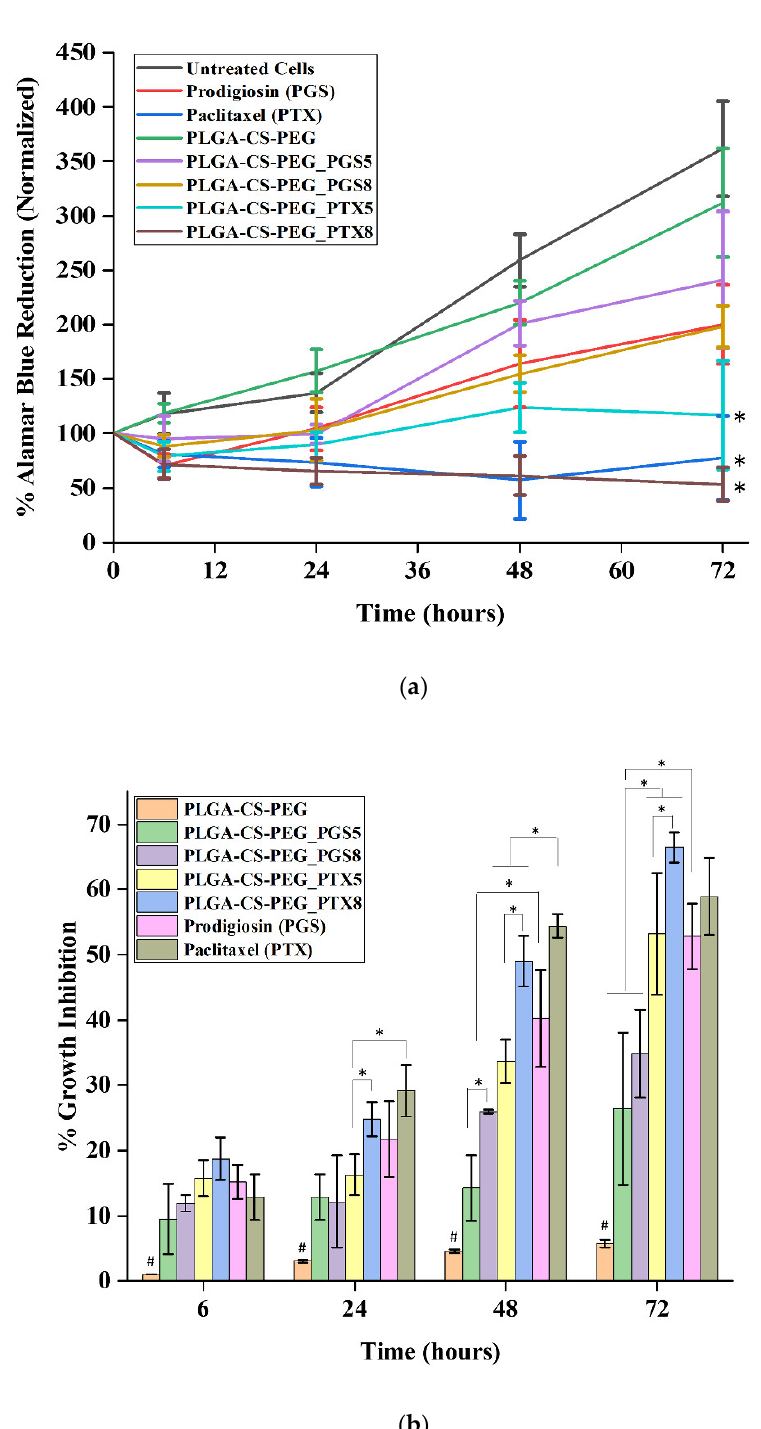
Figure 6. ( a ) Percentage Alamar blue reduction for untreated MDA-MB-231 cells and MDA-MB-231 cells treated with nonloaded microspheres, PGS, PGS-loaded microspheres, PTX, and PTX-loaded microspheres at 6, 24, 48, and 72 h post treatment. Error bars represent the standard deviation for n = 3; * p < 0.05 (significantly different from untreated cells). ( b ) A graph of percentage cell growth inhibition vs. time for MDA-MB-231 cells treated with nonloaded microspheres, PGS, PGS-loaded microspheres, PTX, and PTX-loaded microspheres at 6, 24, 48 and 72 h post treatment. Error bars represent the standard deviation for n = 3; * p < 0.05; # p < 0.05 (significantly lower than the